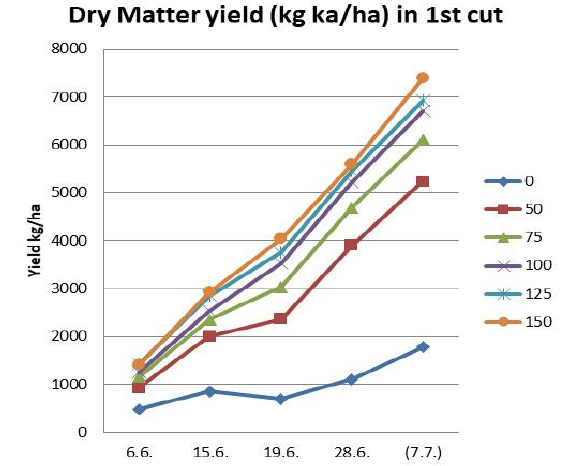
Figure 10 Dry matter yield of the grass sward in first cut as function of harvest time and nitrogen application rates (kg/ha) at the Luke test plots in Jokioinen,